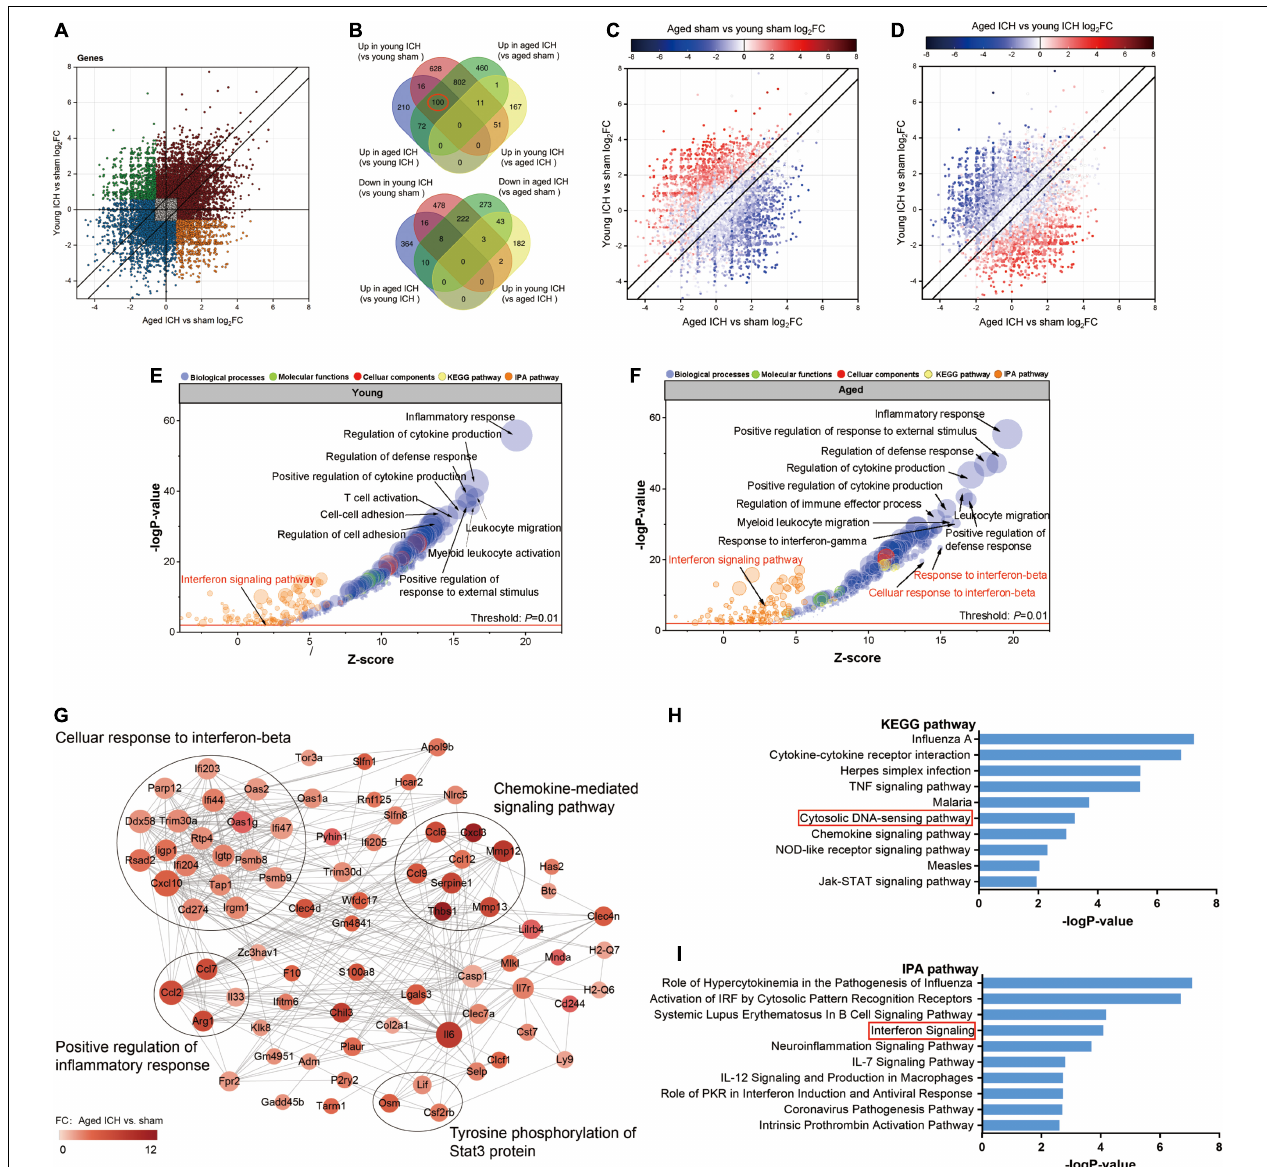
FIGURE 5 | Comparison of differentially expressed genes (DEGs) and functional clusters between young and aged mice with intracerebral hemorrhage (ICH). (A) Scatterplot showing the log 2 foldchange (FC) of genes between young and aged mice after ICH. Genes with an FC > 1.5 or FC < 0.67 are colored. (B) The Venn diagram showing overlap of up- or downregulated DEGs between selected pairwise groups. (C) Scatterplots of the log 2 FC of genes between young and aged mice after ICH. The color of the scatters indicates the log 2 FC of the genes in aged mice vs. young mice after sham surgery (D) or after ICH. (E) Bubble plots comparing ICH-induced alteration in functional clusters from several databases (including Metascape website and Ingenuity pathway analysis (IPA) software) in young mice (F) and aged mice. The Gene Ontology (GO) terms included biological process (BP), cellular component (CC) and molecular function (MF) terms. The size of the bubbles reflects the number of genes in each term, and the color of bubbles reflects the enriched category. (G) Protein-protein interaction (PPI) analysis and (H) Kyoto Encyclopedia of Genes and Genomes (KEGG) pathway enrichment analysis of 100 overlapping genes in the Venn diagram (marked with a red circle), overlapping genes among “upregulated in the young ICH group vs. the young sham group”, “upregulated in the aged ICH group vs. the aged sham group” and “upregulated in the aged ICH group vs. the young ICH group”. In the PPI network, the size of the nodes reflects the degree and the color reflects the FC value of aged ICH vs. sham. The most significant BP in GO enrichment analysis was marked in every module. (I) Pathways in the IPA system associated with genes that showed stronger upregulation after ICH in aged mice (“more upregulated in the aged ICH group”). n = 3 per